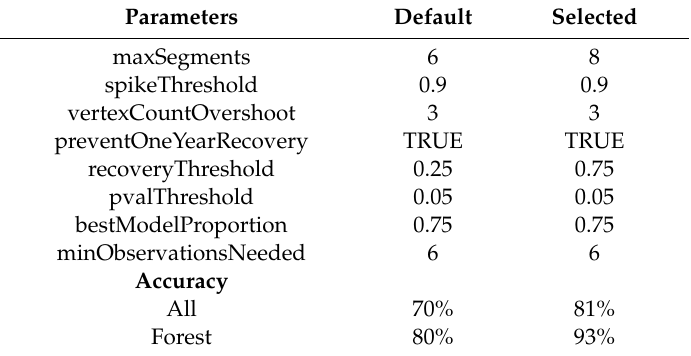
Table 1. LandTrendr parameters. Default: generalized LandTrendr parameters. Selected: LandTrendr parameters that best characterize fire history on Kangaroo Island. Fire Identification: percent of sample pixels in a recorded fire polygon that exhibits an NBR loss of at least 100 during the correct year. Parameters Default Selected maxSegments 6 8 spikeThreshold 0.9 0.9